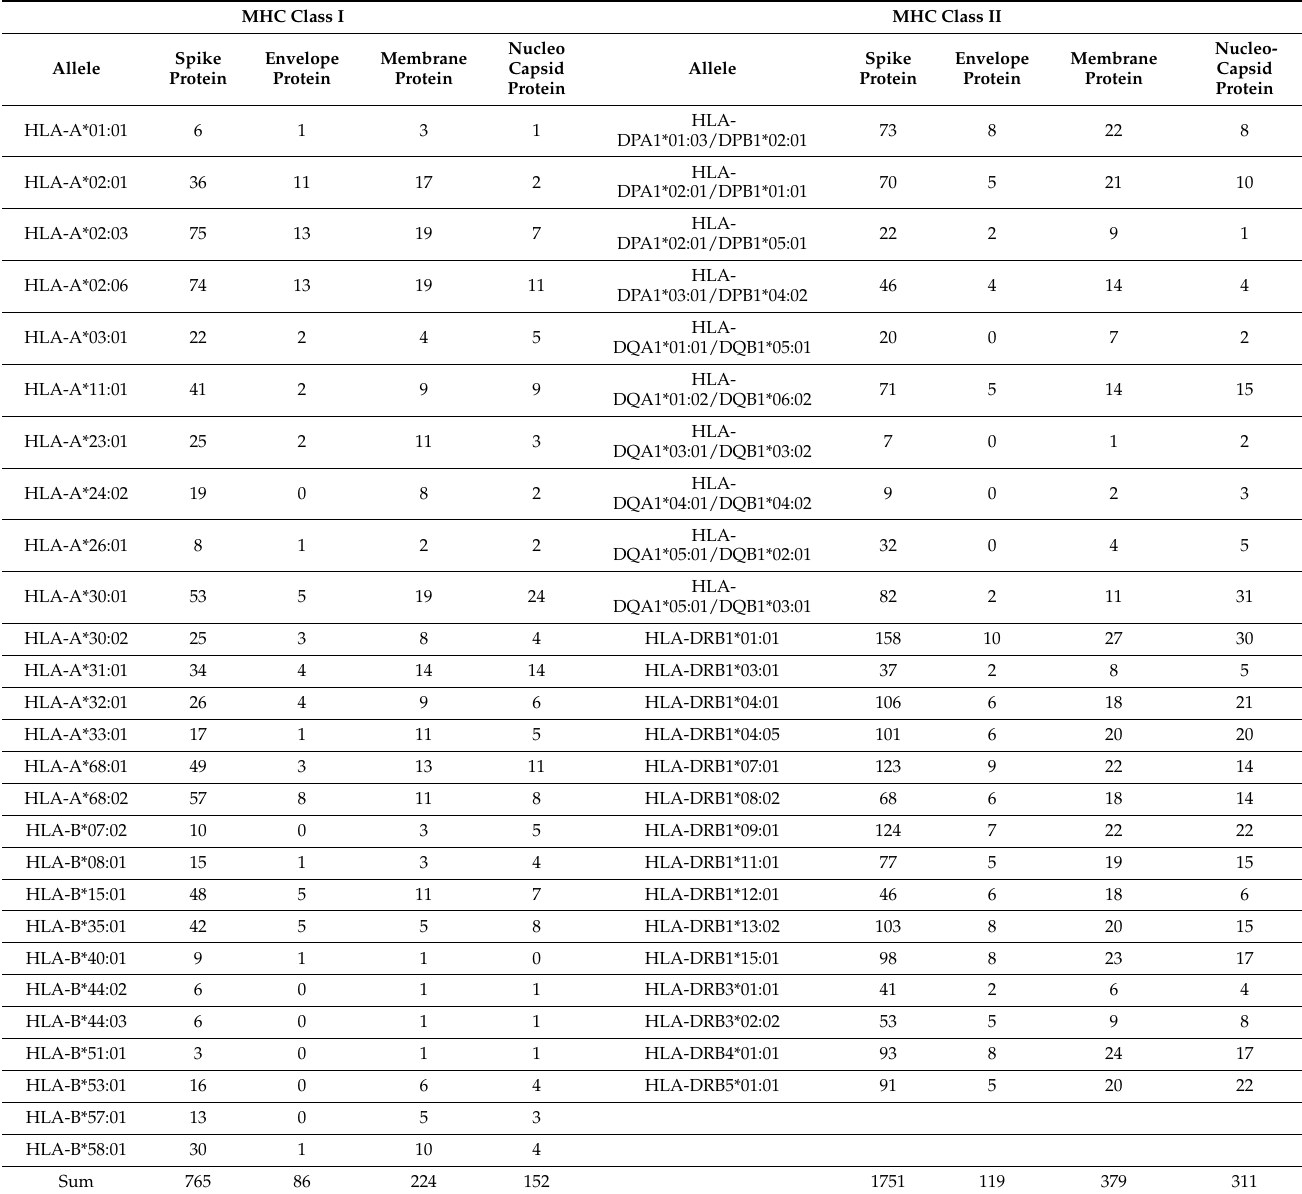
Table 2. Epitopes of structural proteins for each Human Leukocyte Antigen (HLA) allele *. MHC Class